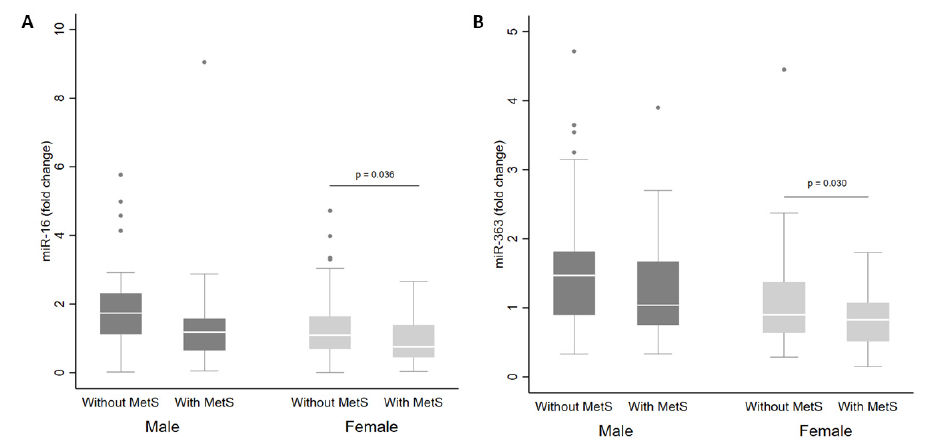
Figure 2. Levels of miR ‐ 16 ( A ) and miR ‐ 363 ( B ) in plasma from adults according to sex and metabolic syndrome (MetS) status. The sample sizes were as follows: male (without MetS n = 57|MetS n = 30); female (without MetS n = 70|MetS n = 35). The comparisons of levels in individuals with and without MetS by sex were conducted using the adjusted Wald test. The box plots depict the 25th–75th per ‐ centile, and the white line represents the median for each group. p < 0.05 indicates statistically sig ‐ nificant differences.